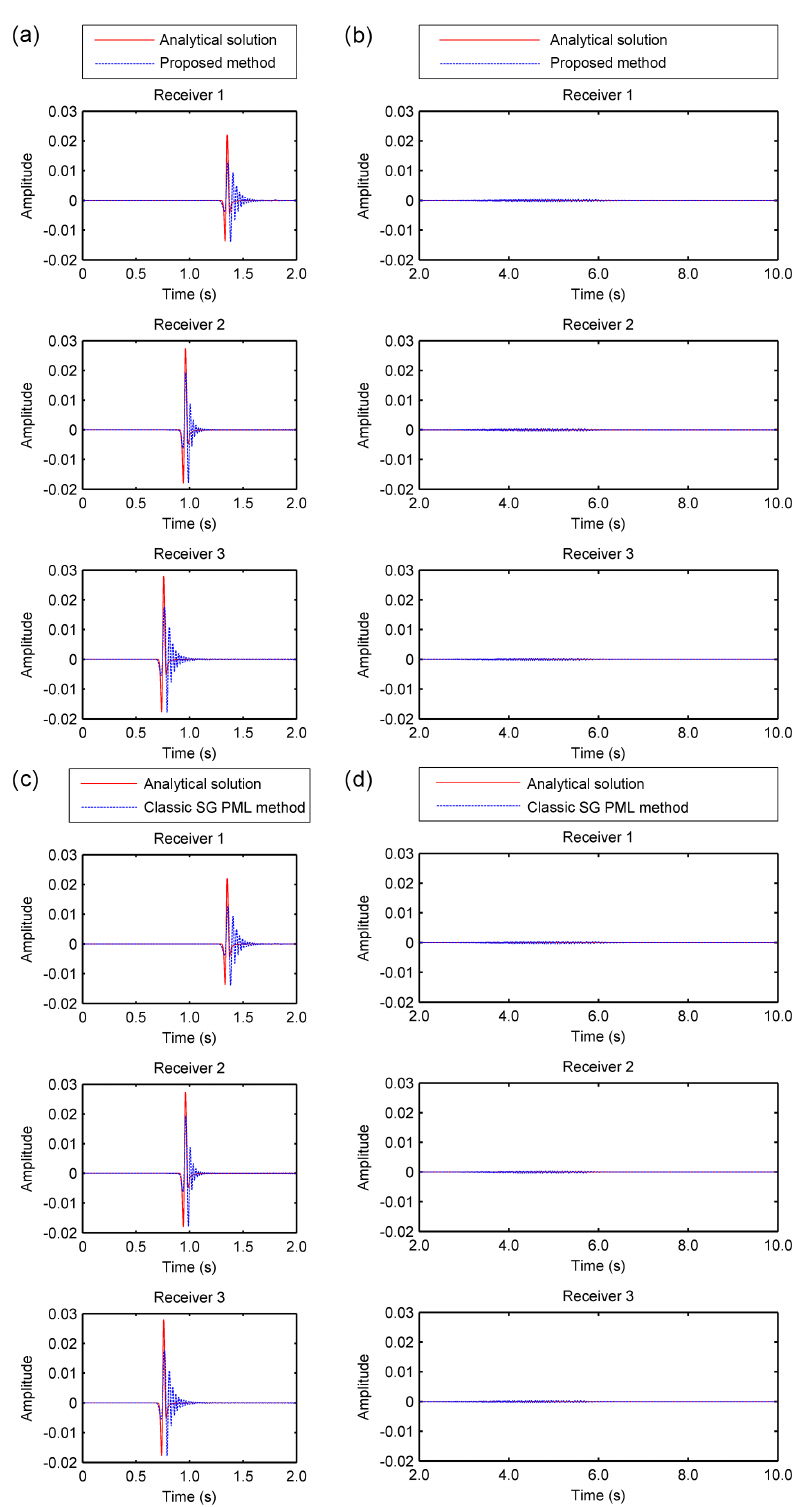
Figure 3. Comparison of the analytical solution (red solid line) with the proposed (second-order conventional grid (CG) scheme) and classic staggered-grid (SG) perfectly matched layer (PML) methods (second-order SG scheme) (blue dotted line) at different receivers, d = 12m. (a) Proposed method at receivers 1, 2, and 3 for the first 2s; (b) proposed method at receivers 1, 2, and 3 after 2s; (c) classic SG PML method at receivers 1, 2, and 3 for the first 2s; (d) classic SG PML method at receivers 1, 2, and 3 after